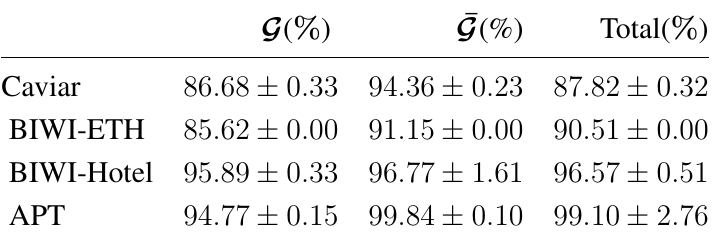
Table 3. Performance rates of the proposed method.